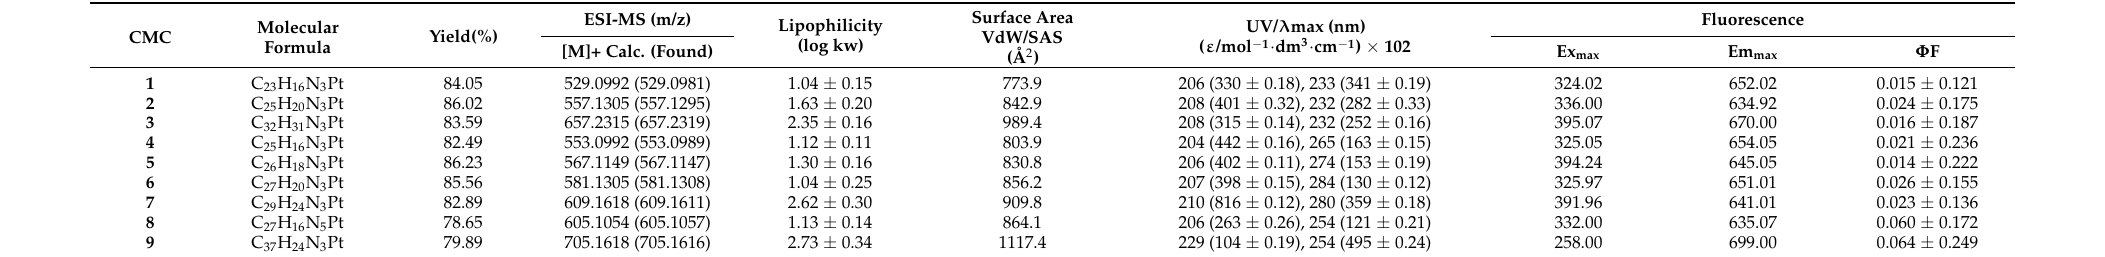
Table 1. Summary of biophysical characterisation of all nine complexes. The correct mass peak was to be identified for each complex using ESI-MS, and no major substructures were seen, suggesting that these complexes are quite stable and pure, which was further demonstrated with HPLC, with each complex achieving HPLC purity above 95% (Supplementary Figures S27–S44).